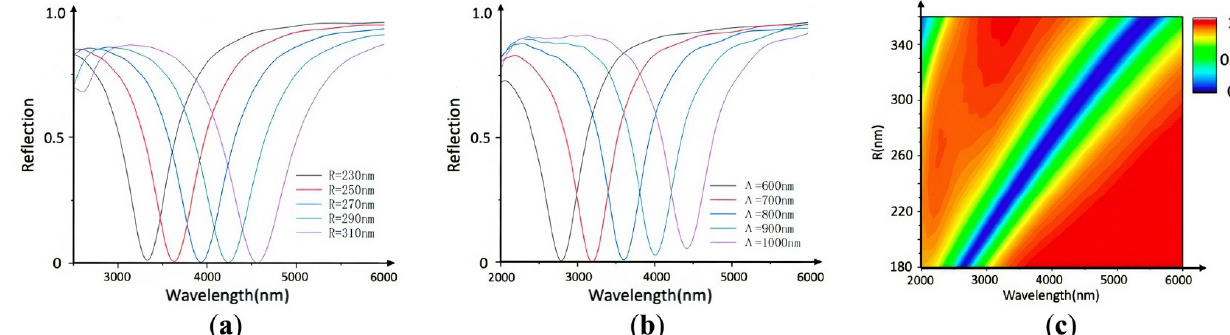
Figure 3. VO 2 film in its insulator phase. ( a ) Change in the reflectance spectrum versus different values of radius R . ( b ) Change in the reflectance spectrum versus the wavelength of the optical switch with disk duty ratio f = 0.3, where the reflectance is calculated for Al nano-disks with different values of the period Λ (where Λ = 600, 700, 800, 900, and 1000 nm). d VO = 50 nm. ( c ) Reflection spectra of the optical switches with different 2